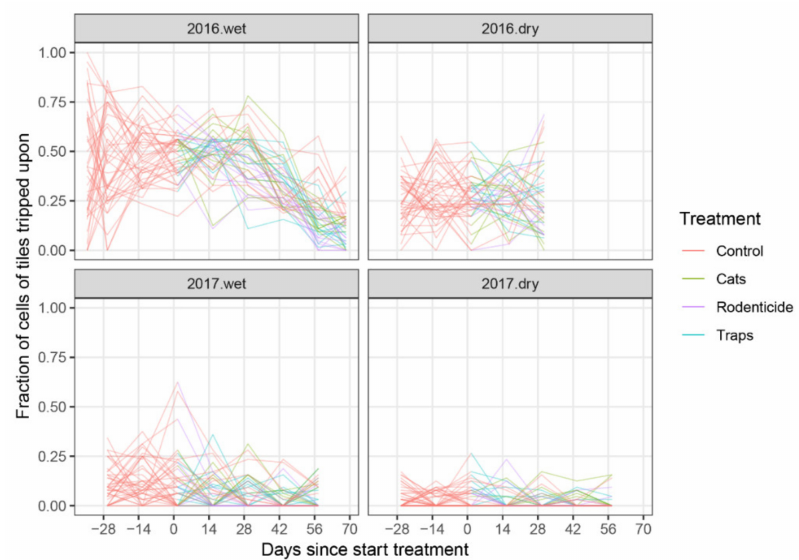
Figure 7. Percentage of tracking tiles marked with rodent footprints, using average values from two locations and two consecutive observation days ( n = 4), split by year and season. Lines connect observations of rodent activity from the same households over time (days).